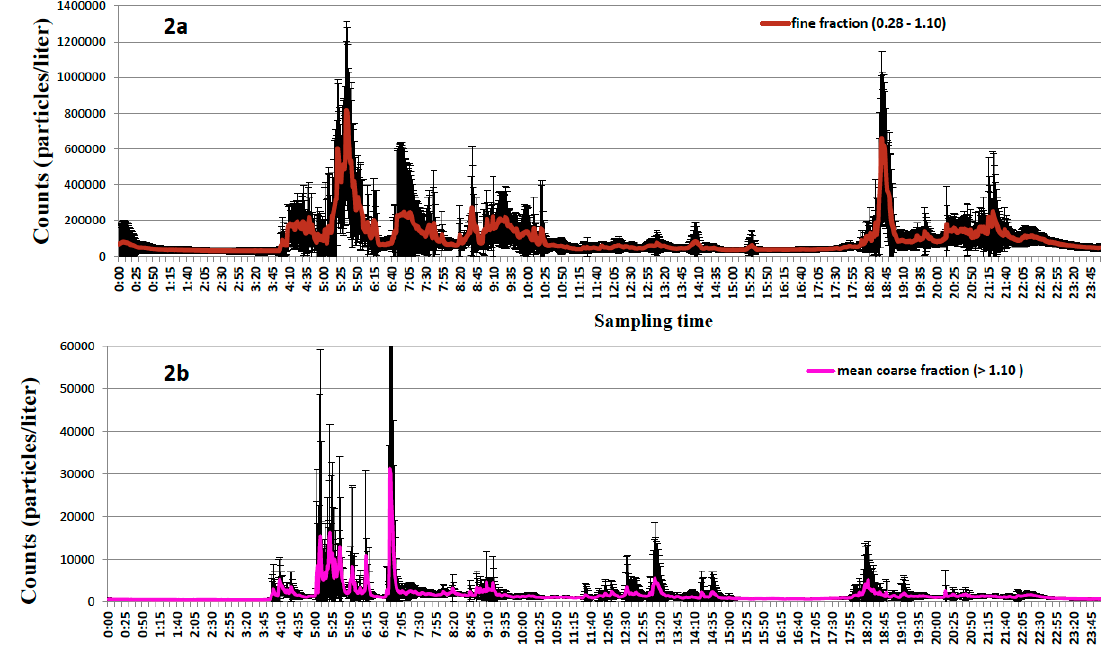
Figure 2. ( a ) Mean fine fraction (0.28–1.10 µm) obtained by considering all bakery working days during the sampling period and ( b ) mean coarse fraction (>1.10 µm) obtained considering all bakery working days during the sampling period.